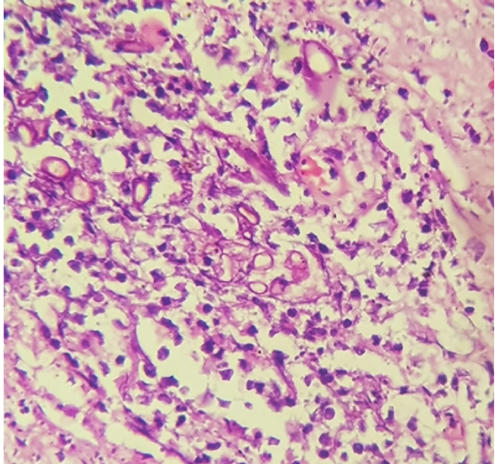
Figure 4b - B, Ring-shaped accumulation of mucormycosis hyphae and spherulas with perifocal cellular reaction and small foci of hemorrhage. Hematoxylin and eosin, x40.